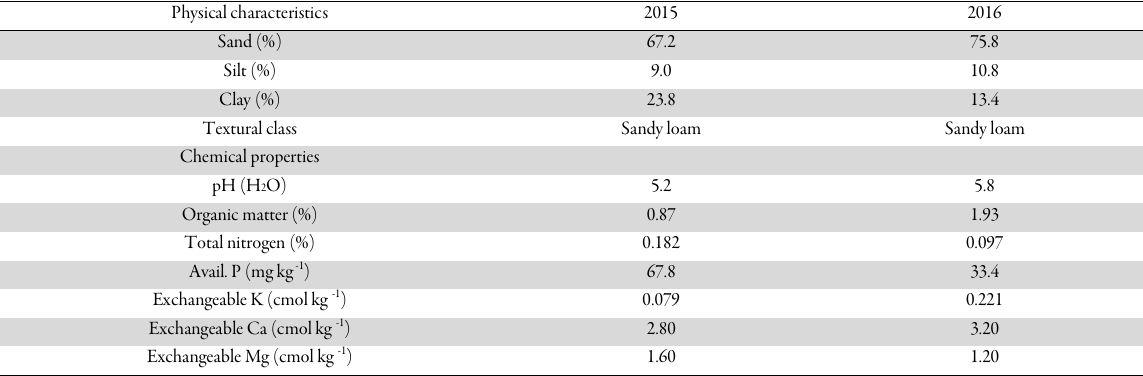
Table 1. Soil analysis of the experimental sites in 2015 and